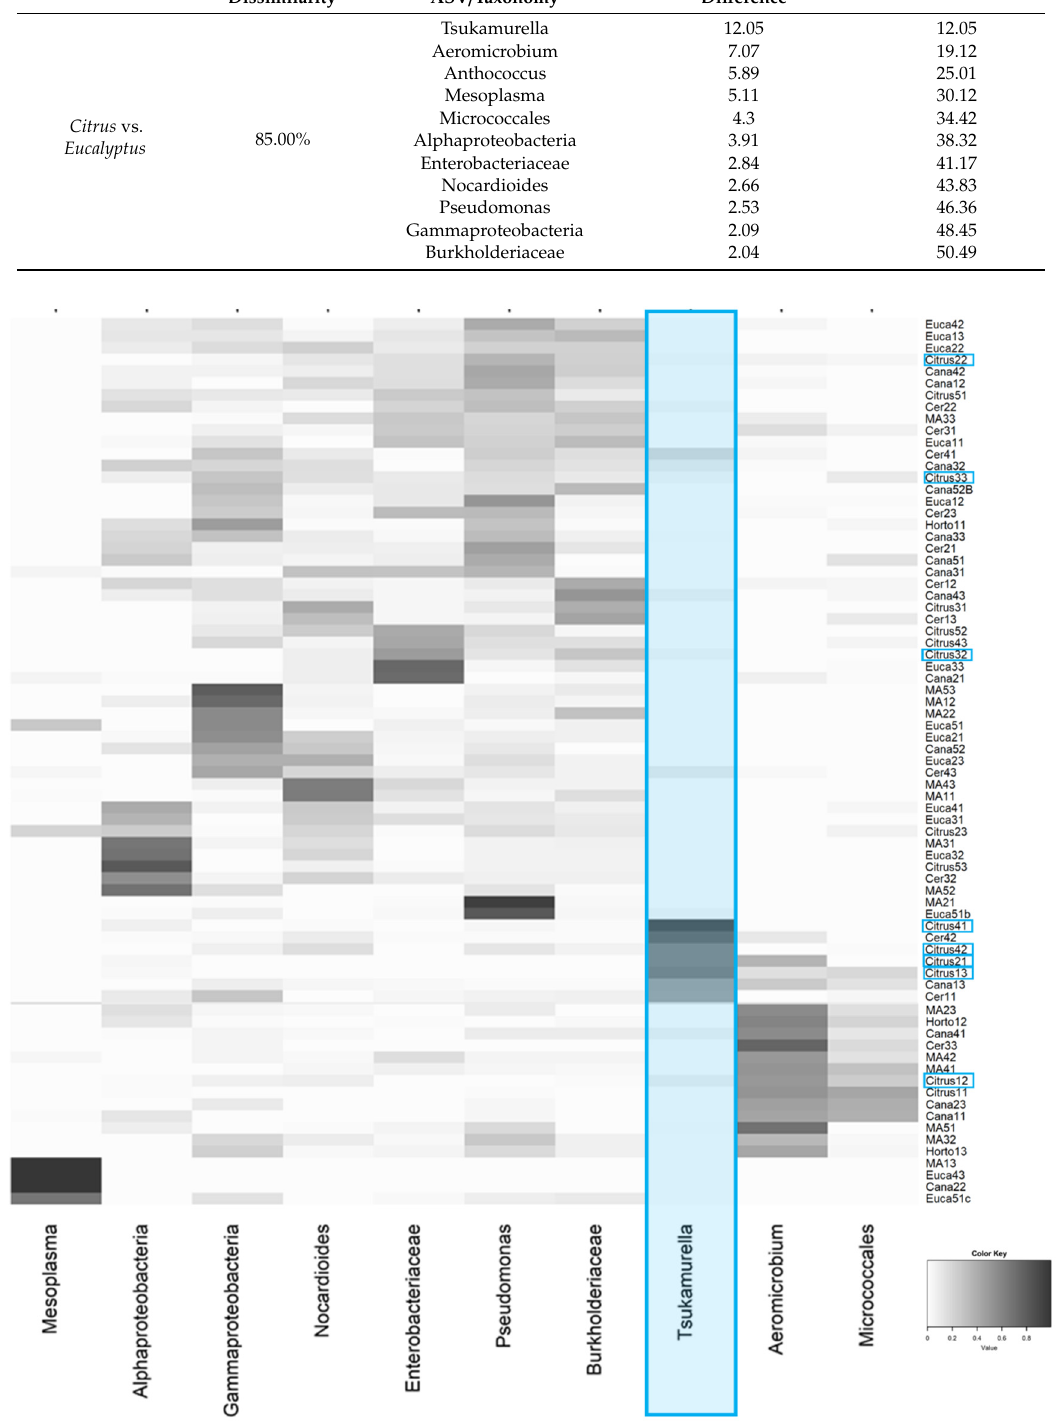
Figure 5. Main bacterial ASVs found in Atta sexdens are visualized in this heatmap. The shading in the heatmap indicate variation in the relative abundance of different bacteria in all samples from this study, ranging from 0% (white) to 100% (black). Highlighted in blue is the Tsukamurella bacteria, which although found in different habitats, is mainly associated with citrus (blue boxes).